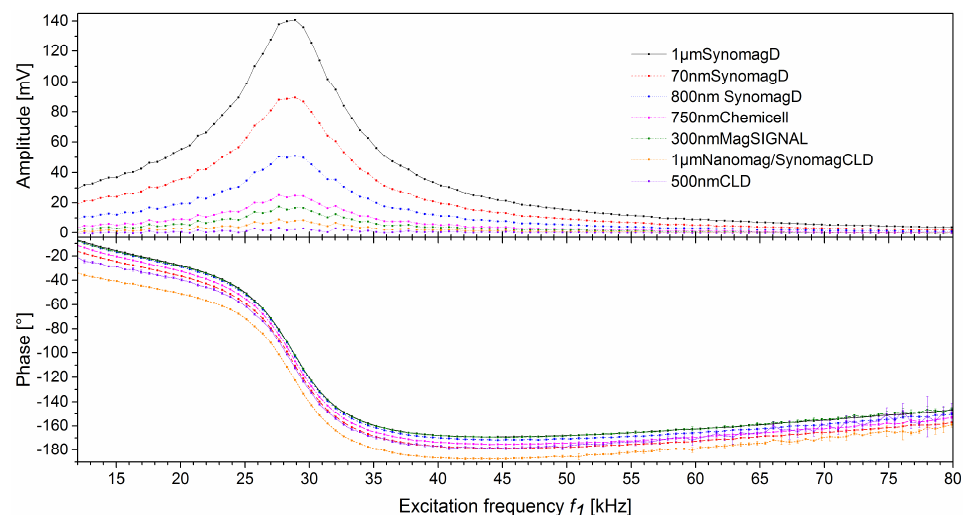
Figure 2. Amplitudes and phases of excitation frequency f 1 scans (mean and standard deviation) with different magnetic bead (MB) types fixed in 3D immunofiltration columns. Numerical data to the plots are listed in Supplementary Materials, Table S1.